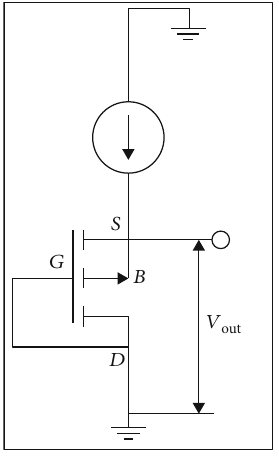
Figure 2: Electronic scheme for reader circuit